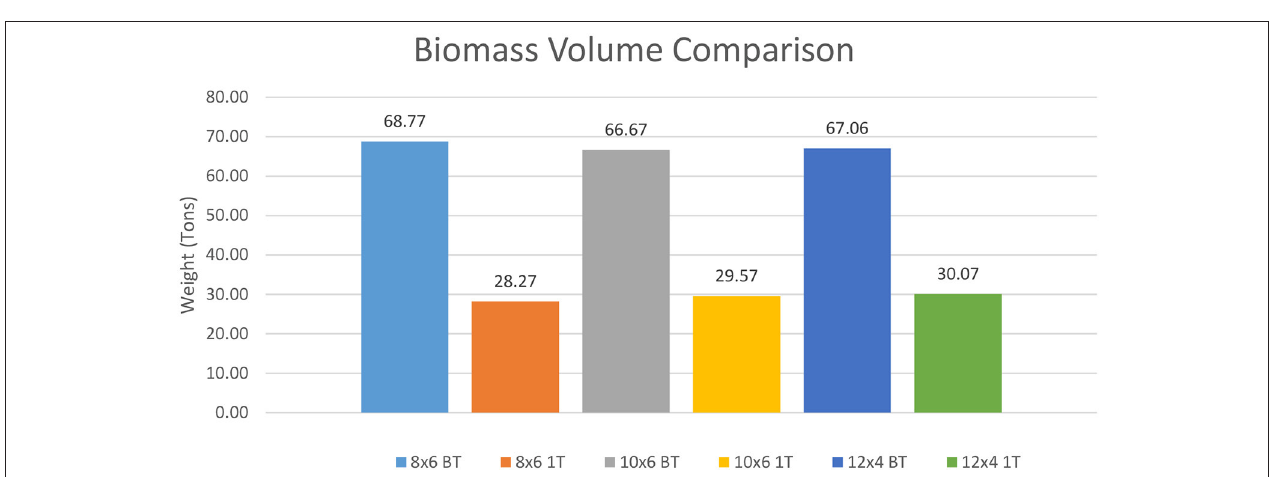
FIGURE 2 | Biomass Volume Comparison for all Ptaeda Models.